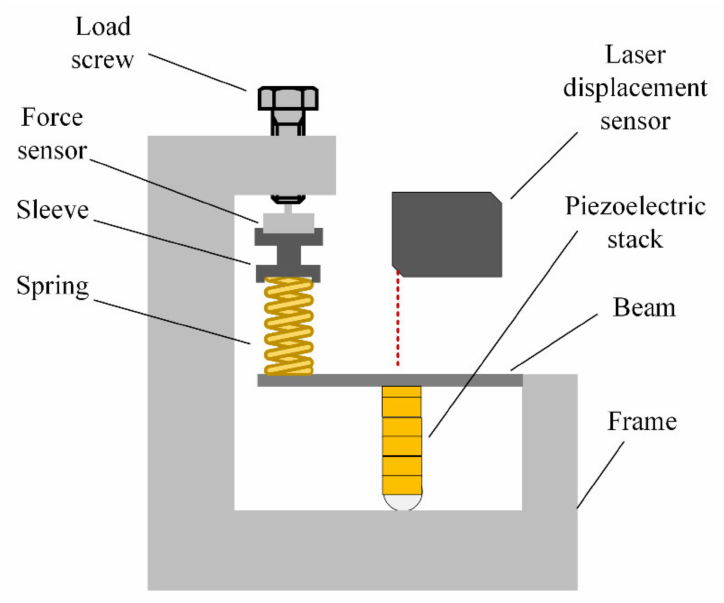
Figure 17. Test system for laminated piezoelectric